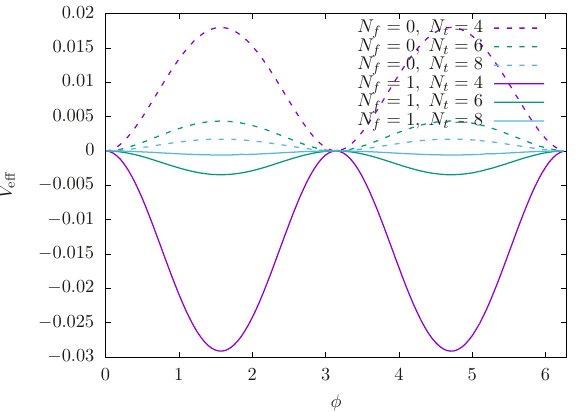
Figure 1 . One-loop effective potential for the Polyakov loop phase φ in SU(2) SYM on the lattice for different N t at m 0 = 0 comparing pure gauge ( N f = 0) and SYM ( N f = 1). The SYM effective potential is different from zero due to lattice artefacts. It is confining and the expected flat behavior is reached only asymptotically at large N t . The potentials are normalized to zero at φ = 0 in this